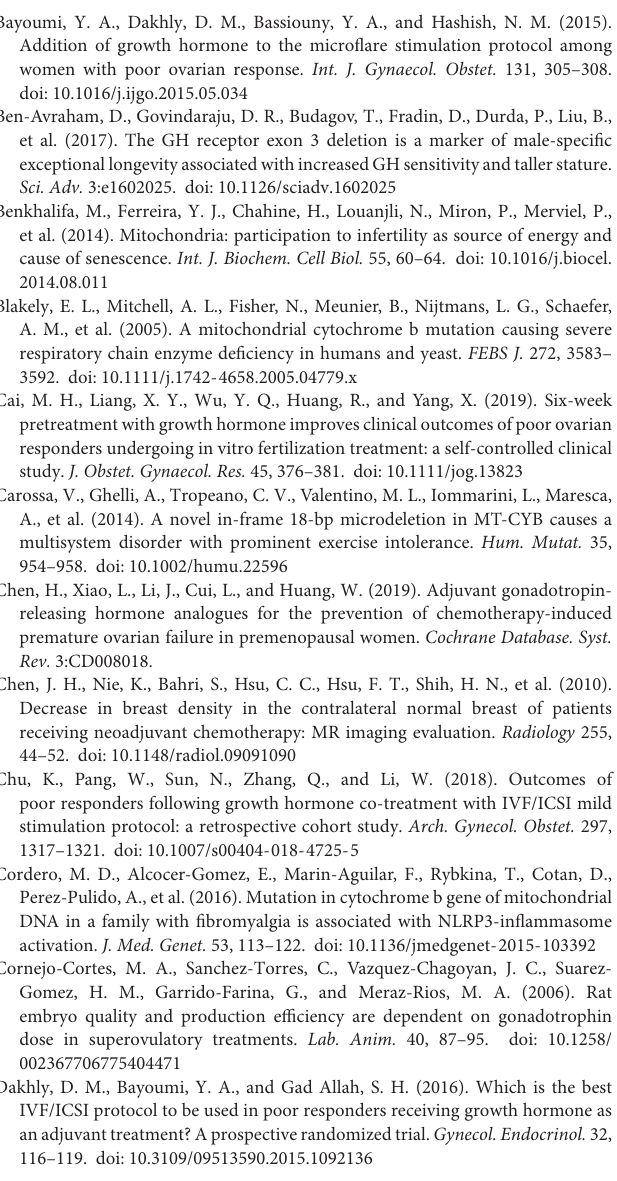
meta-estrus (M) (c) and diestrus (D) (d) . scale bar = 200 µ m, × 100 magnification. (B) Typical dynamic trends of the estrous cycle for each group. (C) Enumeration of the estrous cycle ranging from the initiation of rhGH treatment to the fourth week after therapy. Supplementary Figure 2 | Protein-protein interaction network of DEGs. (A) The interactive relationship was identified, and genes belonging to different functional modules were distinguished by various colors. Supplementary Figure 3 | Model establishment of DEGs after CTX treatment. (A) Lasso coefficient profiles of CTX-treatment-related mRNAs. (B) Partial likelihood deviance was calculated by the cross-validation for the best lambda to determine minimum mean cross-validated error. (C) Expression heatmap of the four selected hub genes. (D) Expression correlation among the four genes. (E) Nomogram of the hub genes. The total points were applied for evaluating the chance of the POI. (F) Forest plot odds the odds ratio of the four hub genes by regression